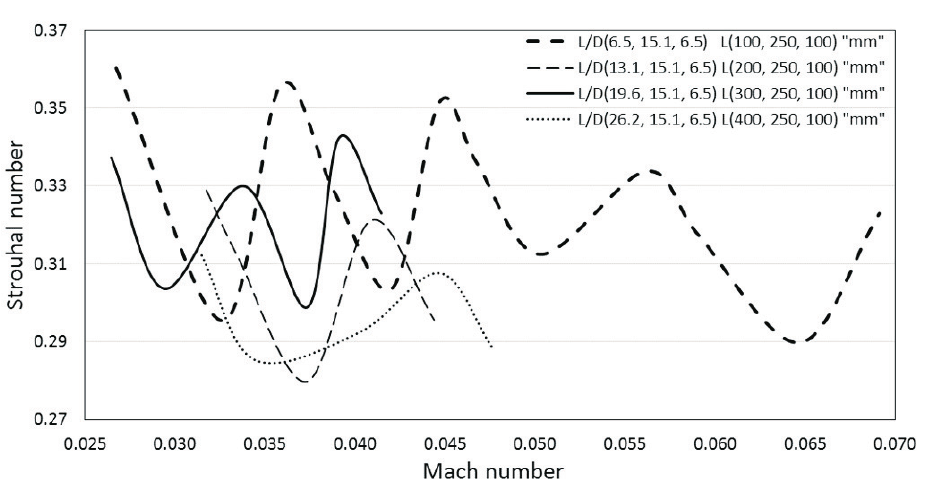
Figure 15. Strouhal number St plotted against Mach number M for L up = 100–400 mm, L corr = 250 mm, and L dw = 100 mm.